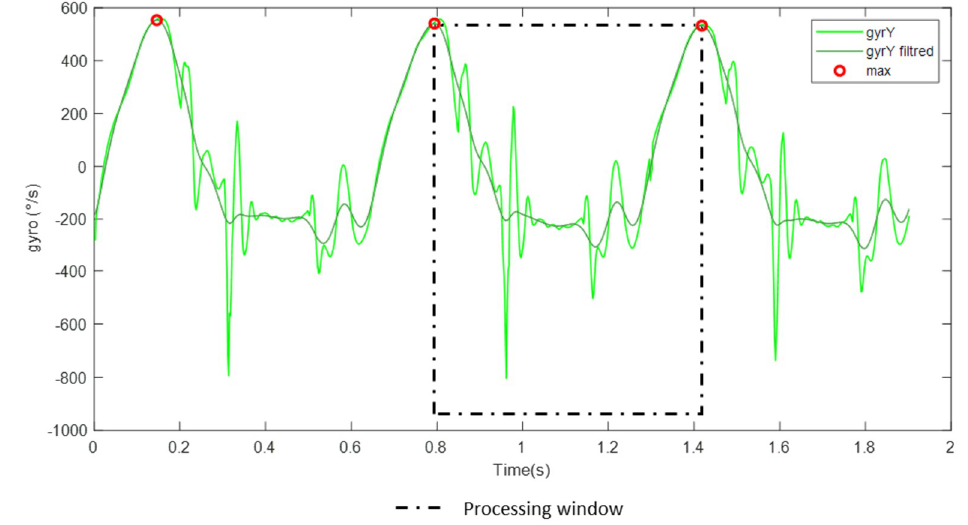
Figure 3. Representation of the Y‐axis gyroscopic filtered signal used for the pre‐segmentation